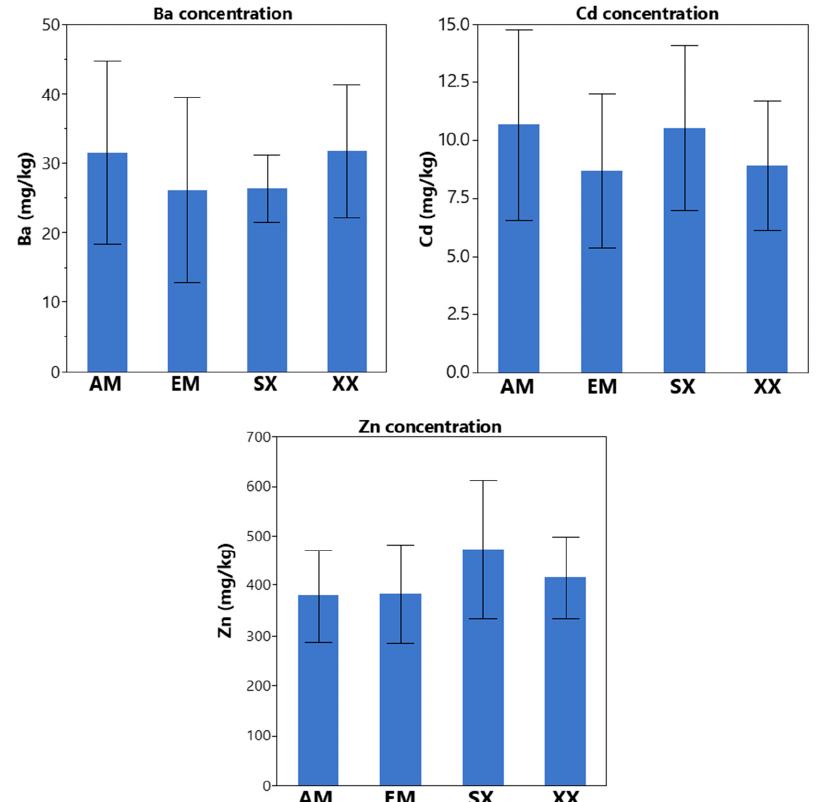
Figure 3. Ba, Cd, and Zn were the only TE detected in the stem tissue of the Salix miyabeana SX67 plots ( n = 5 for each treatment), though there were no significant differences in the average concentrations between treatments. Error bars represent standard deviation. SX = Willow non-inoculated; AM = Willow + AMF inoculation; EM = Willow + ECM inoculation; XX = Willow + AMF + ECM inoculation; CN = Non-planted control.